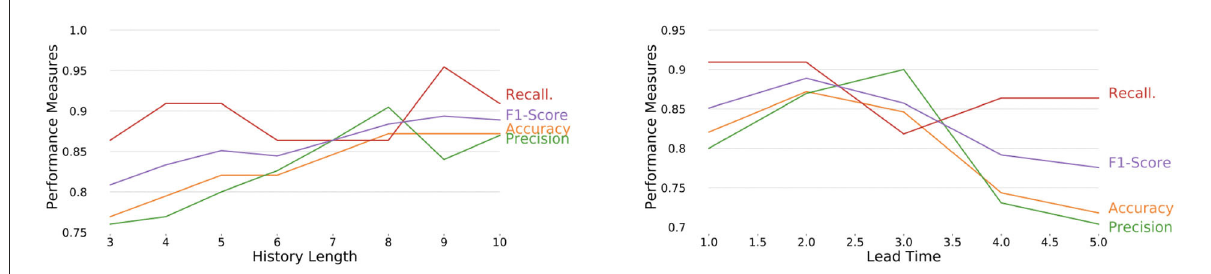
FIGURE4 Performance measures of EPIAL over various history lengths (left ), and lead times (right) for the city of Brasilia with a context window size of 10.